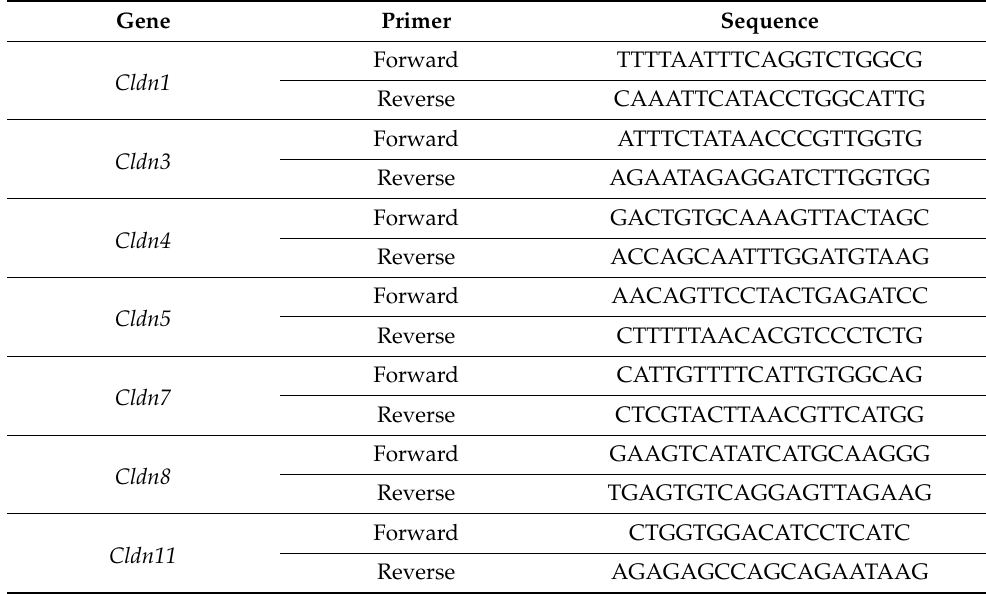
Table 1. Primer sequences of tight junction genes and the housekeeping